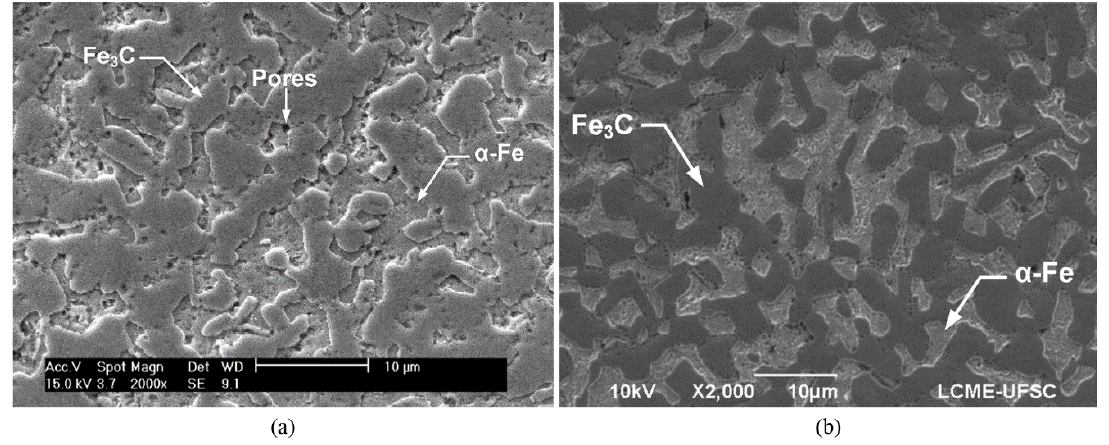
Figure 10. SEM surface micrographs of the samples carburized for 3 hours at 700 °C: (a) 5% CH